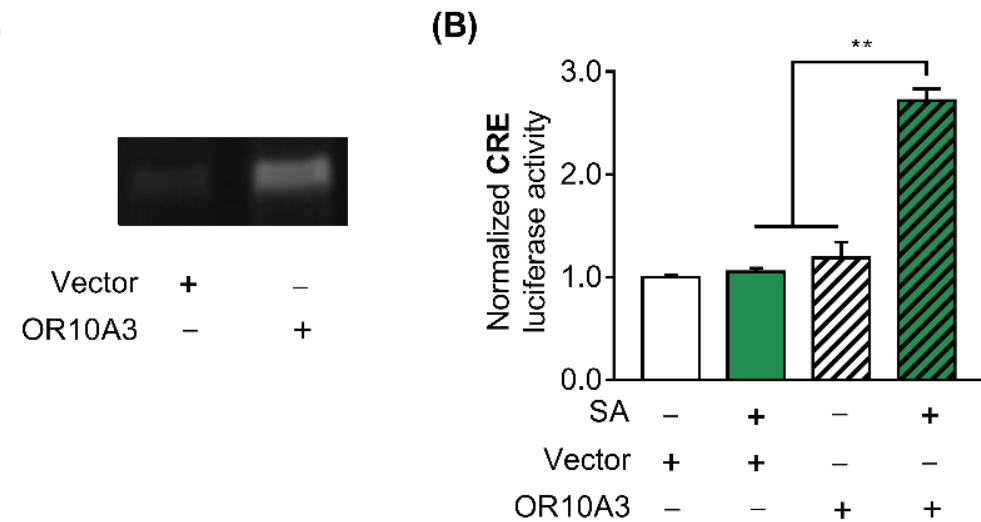
Figure 4. The treatment with suberic acid led to the activation of OR10A3. ( A ) Control plasmid vector or plasmid harboring OR10A3 were introduced into HEK293T cells. The cells were harvested after 48 h and the overexpression of OR10A3 was verified by a semi-quantitative PCR in OR10A3- transfected HEK293T cells. ( B ) HEK293T cells were co-transfected with the plasmids encoding OR10A3, RTP1S, Golf, and Ric8b, pCRE-luc, and pRL-TK for 48 h. Then, the cells were incubated with vehicle control or suberic acid (SA; 100 uM) for 6 h, and CRE promoter activity was analyzed using the dual-luciferase assay. The results are expressed as the mean SEM of three independent experiments. ** p < 0.01.